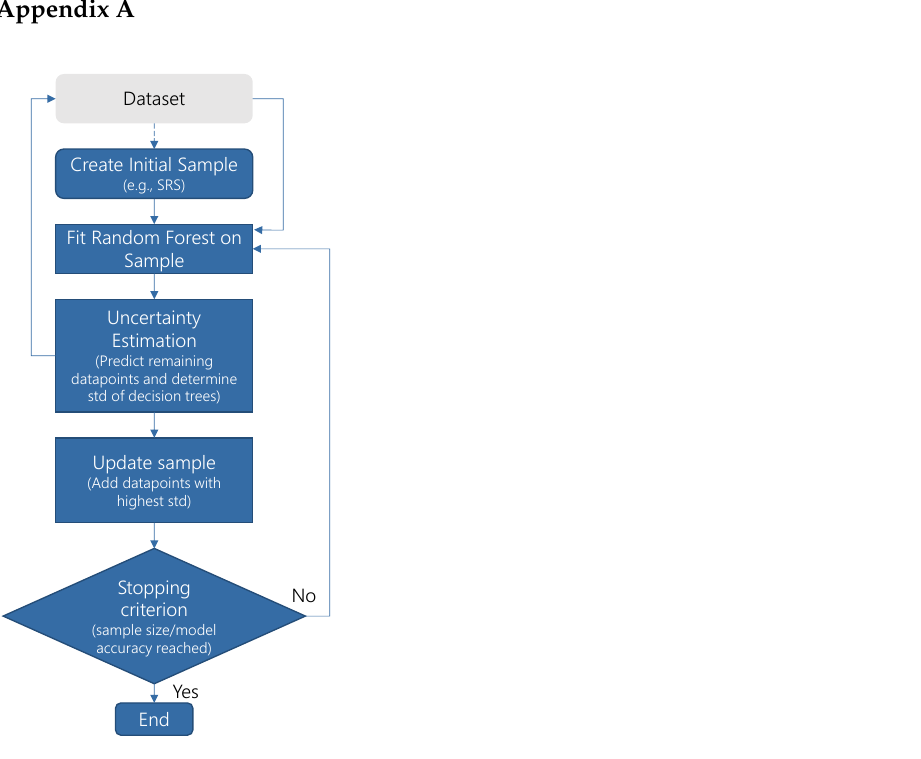
Figure A1. Flow chart of our adaptive sampling scheme as implemented in this work.